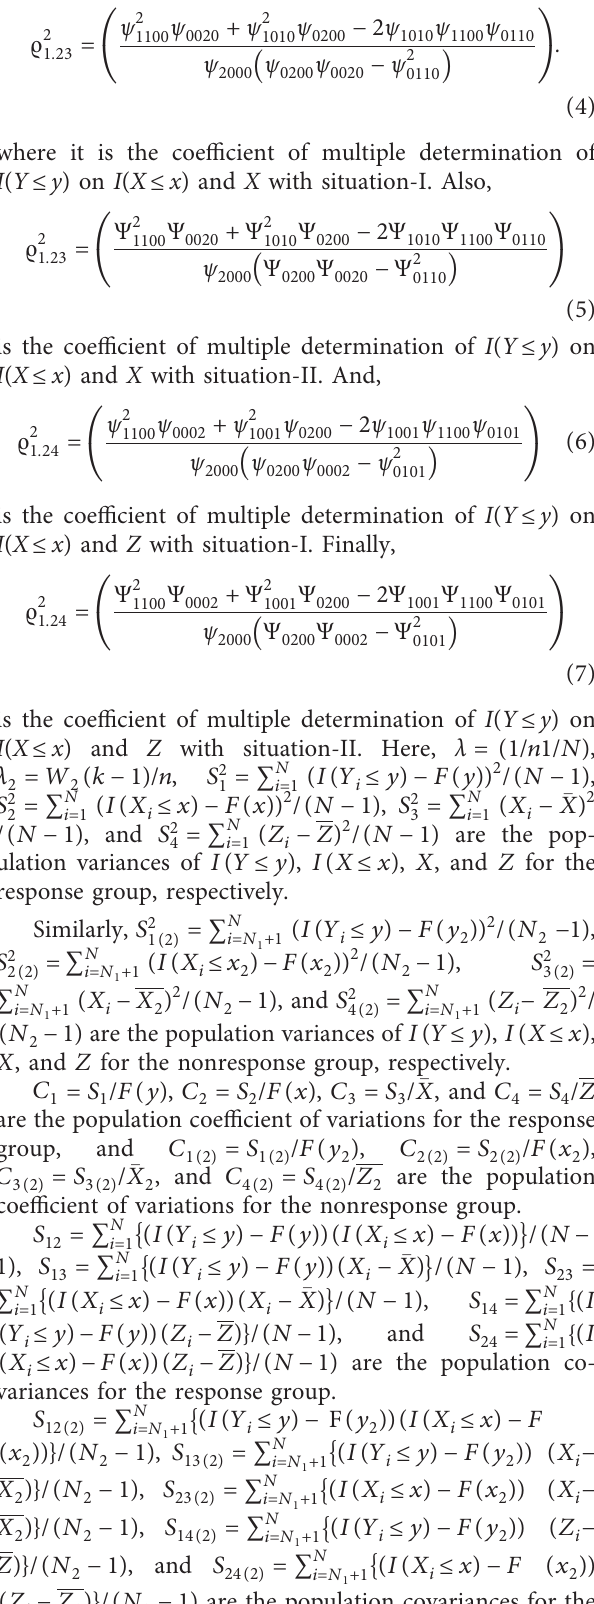
Here, Table 1: Estimators, variances, covariances, and correlation under